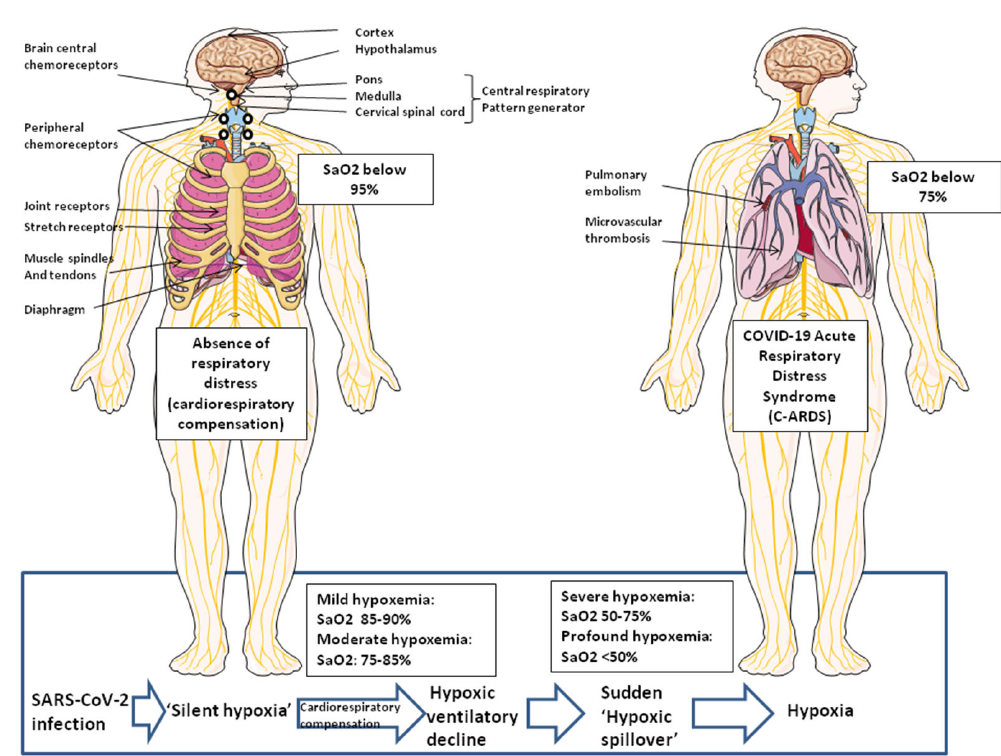
Figure 5. Physiologic mechanisms governing the control of breathing. Peripheral chemical and mechanical sensory receptors are involved in the control of breathing and the sensation of dyspnea. Peripheral chemoreceptors located in the aortic arch and the carotid arteries act as sensors for both O 2 tension and CO 2 tension. Pulmonary alveolar walls receptors include joint receptors and stretch receptors. Chemoreceptors in the central and peripheral airways act as irritant sensors. Mechanoreceptors located on the ribs provide information regarding displacement, while muscle tendons provide infor- mation regarding tension development. Muscle spindles provide integrated information. The central nervous system integrates these signals and governs breathing (neurons that regulate breathing are widely dispersed in the central cortex, the hypothalamus, the limbic/paralimbic system, pons, and medulla). In moderate hypoxemia, patients respond with intense cardiovascular response (e.g., in- creased tachycardia, cardiac output, and systemic arterial blood pressure) and accelerated breathing. In contrast, profound hypoxemia (SaO 2 below 50%) is associated with cardiovascular collapse that results in loss of consciousness, bradycardia, and shock. The ‘hypoxic spillover’ corresponds to sudden deterioration in both oxygen saturation and cardiovascular compensation. For more details, see reference